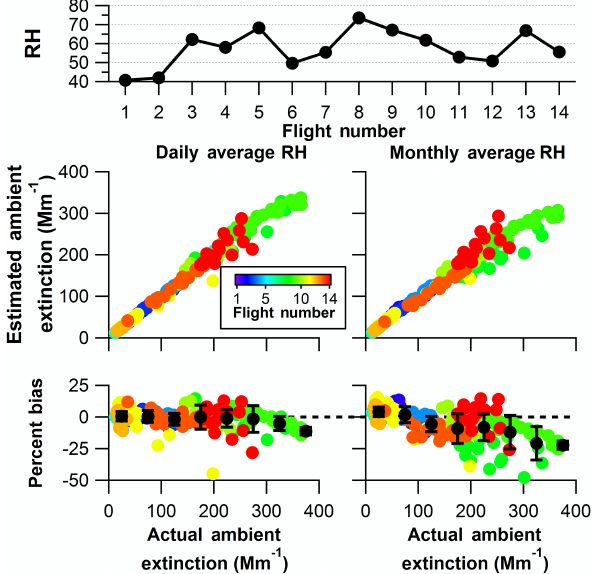
Figure 15. Average dry extinction for each flight (top) along with estimated ambient extinction and percent bias if the flight-average (left) and campaign-average (right) dry extinction are used.